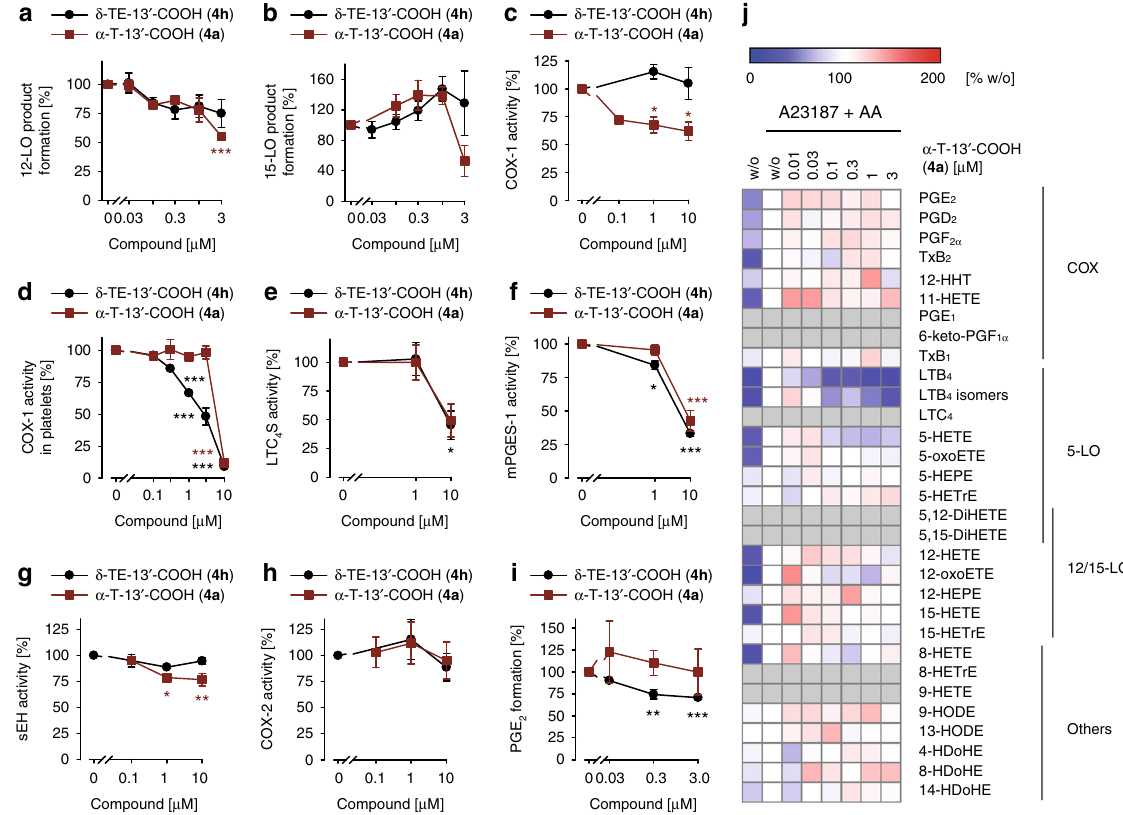
Fig. 4 Moderate and subordinated effects of α -T-13 ′ -COOH ( 4a ) within eicosanoid and docosanoid biosynthesis. a – i Effects of α -T-13 ′ -COOH ( 4a ) and δ - TE-13 ′ -COOH ( 4h ) on the biosynthesis of 12- ( a ) and 15-LO-derived products in A23187/AA-activated PMNL ( b ), isolated bovine COX-1 ( c ), COX-1- dependent 12-HHT formation in platelets ( d ), human recombinant LTC 4 synthase (LTC 4 S) ( e ), mPGES-1 in microsomal preparations of IL-1 β -treated A549 cells ( f ), human recombinant sEH ( g ), human recombinant COX-2 ( h ), and COX-2-dependent PGE 2 formation in LPS-activated monocytes that were treated with A23187 plus AA ( i ). j Heatmap showing the concentration-dependent effect of α -T-13 ′ -COOH ( 4a ) on the lipid mediator pro fi le in A23187/ AA-treated monocytes that were pre-activated with LPS. Tx thromboxane, HTT hydroxy-heptadecatrienoic acid, oxoETE oxo-eicosatetraenoic acid, HEPE hydroxy-eicosapentaenoic acid, HETrE hydroxy-eicosatrienoic acid, (Di)HETE (di)hydroxy-eicosatetraenoic acid, HODE hydroxy-octadecadienoic acid, HDoHE hydroxy-docosahexaenoic acid. Mean± s.e.m. ( a – i ) and mean ( j ) from n = 3 ( a – d , f – j ), n = 5 ( e ) independent experiments. * P < 0.05, ** P < 0.01, *** P < 0.001 vs. vehicle control; repeated measures one-way ANOVA + Tukey HSD post hoc